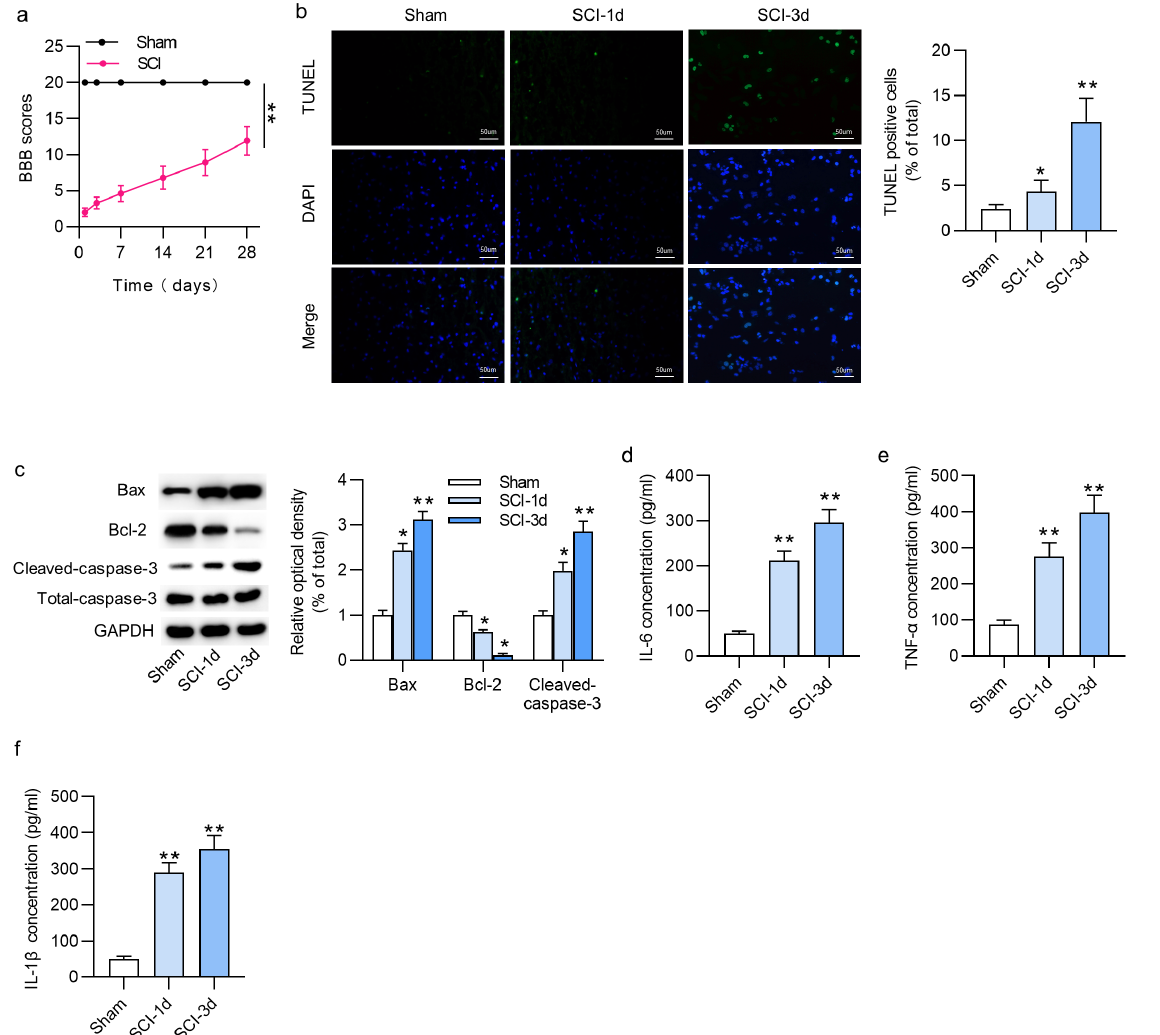
Figure 1. SCI induced the increase of the cell apoptosis and inflammation. (a) The behavioral analyses of the mice were measured via Basso, Beattie, and Bresnahan (BBB) scores. (b) Cell apoptosis in the SCI group and sham group was examined by use of TUNEL assay. (c) Western blot analysis was employed to evaluate the protein levels of apoptosis associated genes (Bax, Bcl-2 and Cleaved-caspase-3). (d-f) ELISA was performed to detect the concentrations of proinflammatory cytokines (IL-6, TNF-α and IL-1β) in the mouse serum. N=5 in each group. * p < 0.05. ** p <